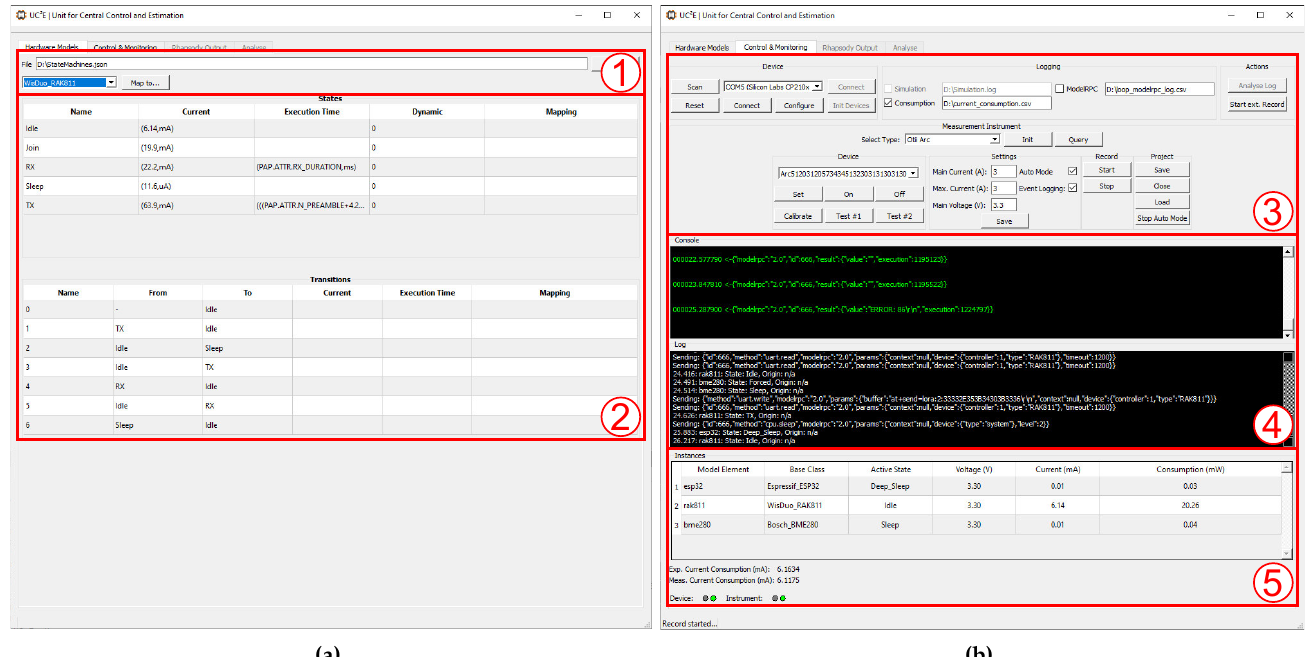
Figure 14. Screenshots of the UC 2 E tool showing the configuration and analysis views. The Config- uration view ( a ) is used to import (1) hardware component models and tabular presentation of the extracted energy model (2). Control & Monitoring view ( b ) is used to configure the tool, measuring unit, and ModelTestBed (3). During simulation, interaction between the software application model and the ModelTestBed (4) are displayed along with the expected state for each hardware component as well as the expected and measured current consumption of the system